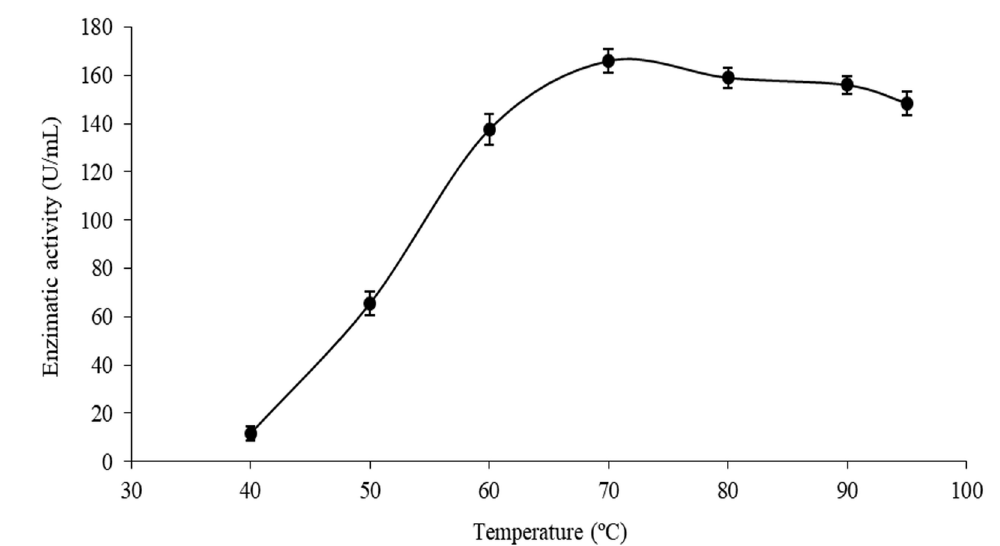
FIGURE 4A - Enzymatic activity in the production of β -CD as a function of temperatures of 40 to 95 °C using 10% (w/ V) cassava starch in the presence of 10% (V/V) ethanol.